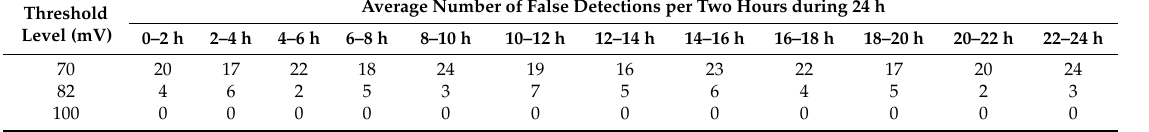
Table 1. Average number of false detections at three sensing threshold levels (70, 82 and 100 mV) during 24 h.